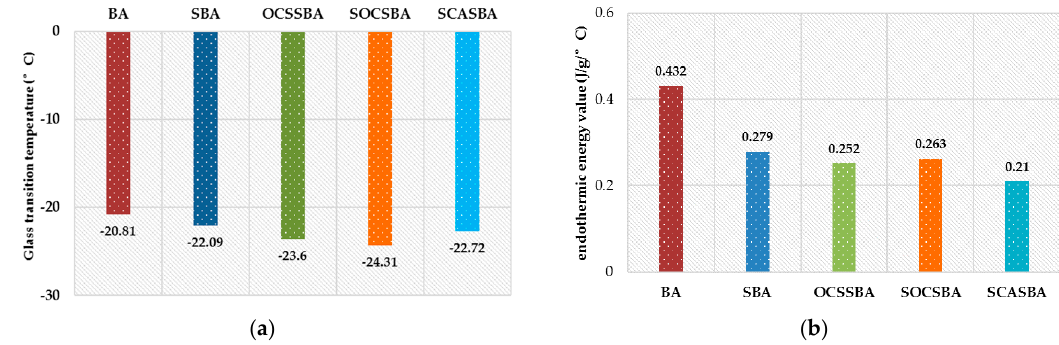
Figure 9. Differential scanning calorimetry (DSC) results of the neat and modified asphalt binders. ( a ) Glass transition temperature of the neat and modified asphalt binders; ( b ) Endothermic energy value of the neat and modified asphalt binders.